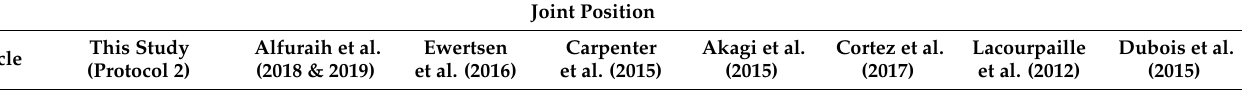
Table 2. Summary of different positionings for muscle ultrasound SWE, sorted by muscle and by